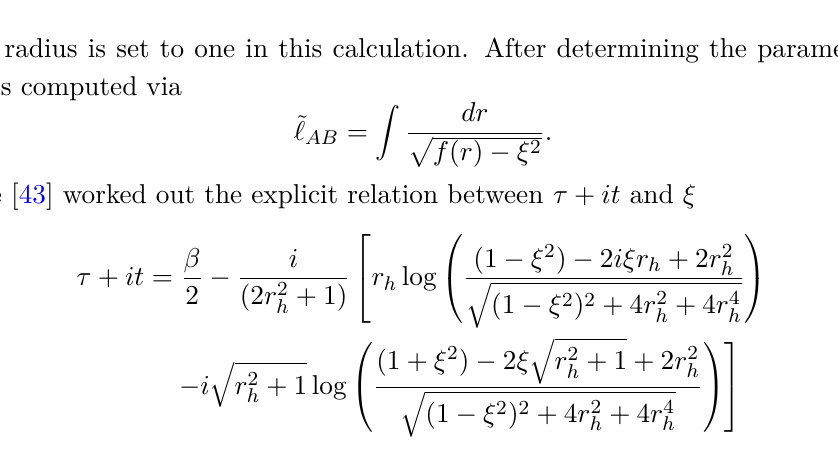
Figure 11 . Computing the distance between the two